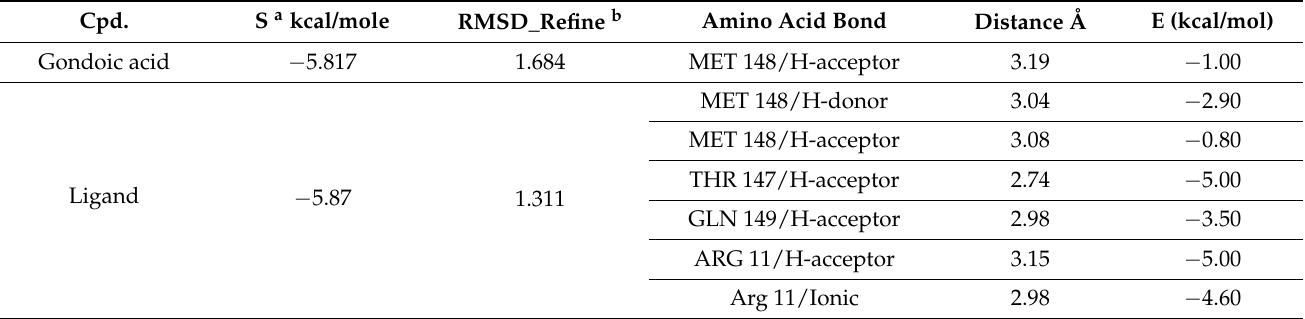
Table 2. Receptor interactions and binding energies of gondoic acid and ligand into the active pocket site of IL-1 β catalytic domain.